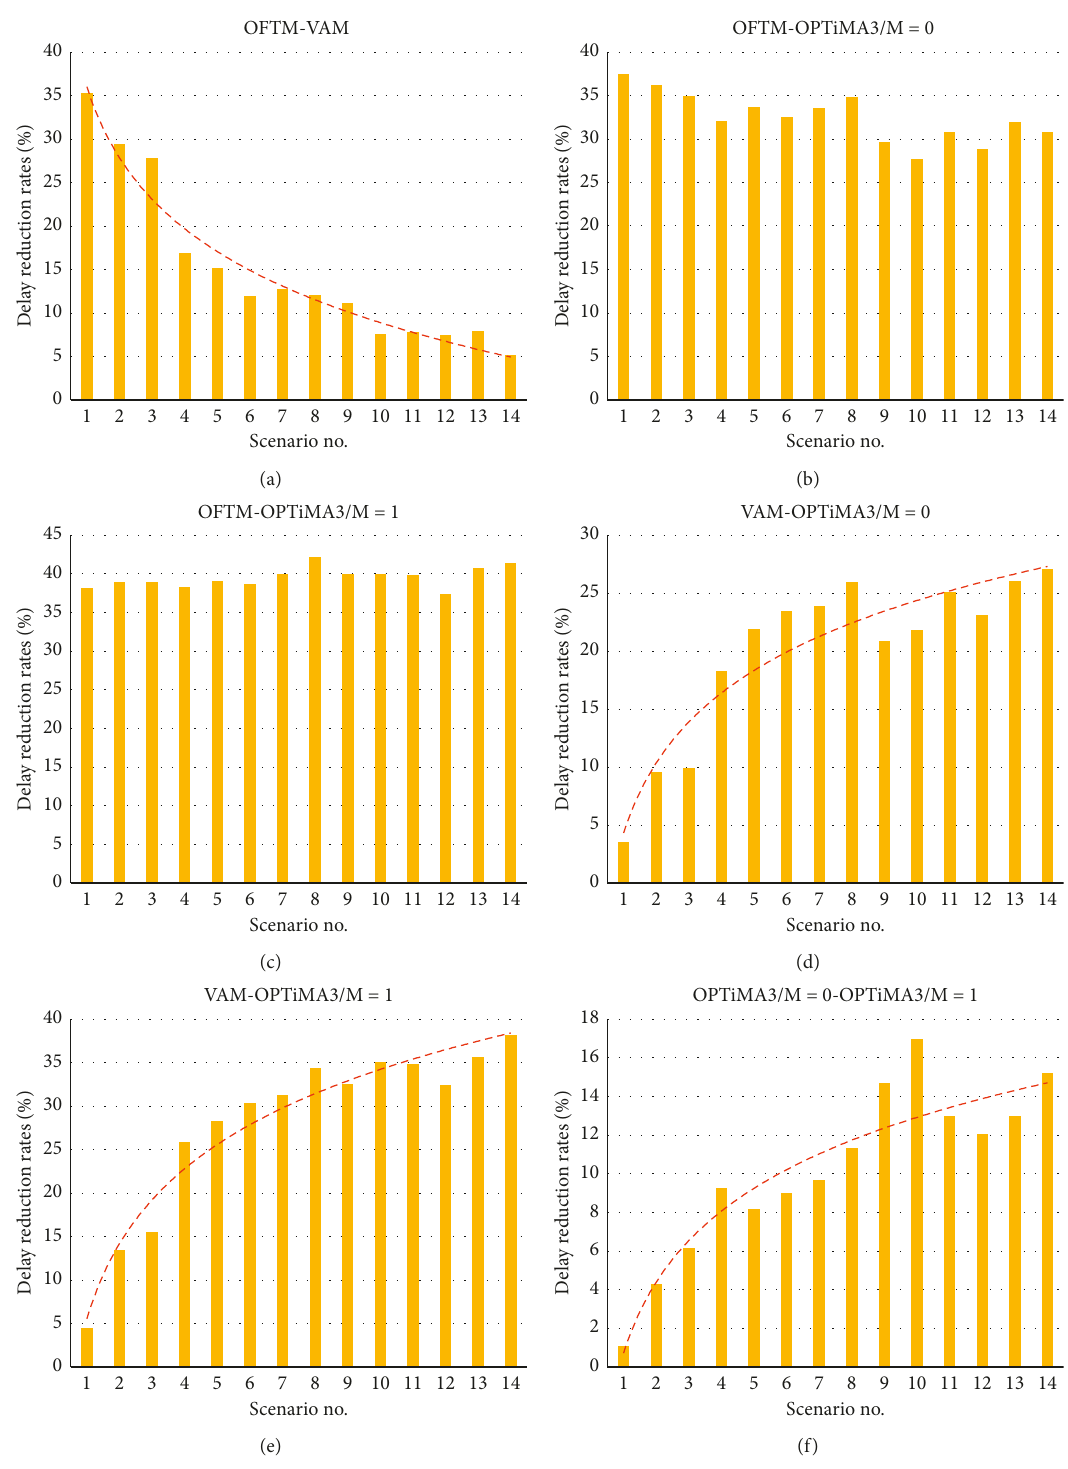
Figure 10: The comparison of achievements for different intersection management